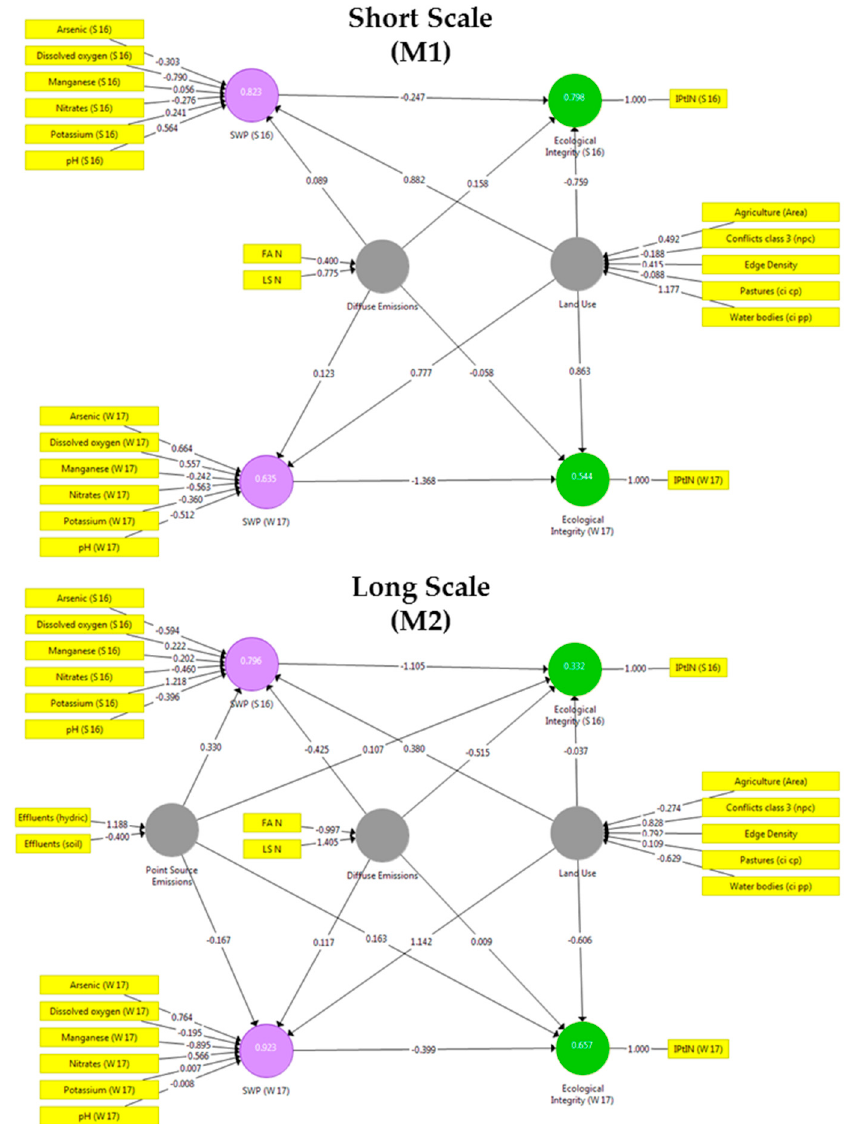
Figure 4. PLS-PM models. The short-scale model (M1, upper panel) involves the assessment of pressures within 250 m buffer zones around the sampling sites. The long-scale model (M2, lower panel) involves the assessment of pressures within the drainage areas located upstream of the sampling sites. Table 1 explains the symbols (e.g., FA N). Yellow boxes represent measured variables and blue circles, latent variables. Between measured variables and latent variables are represented weights, and between latent variables the path coefficients are established.